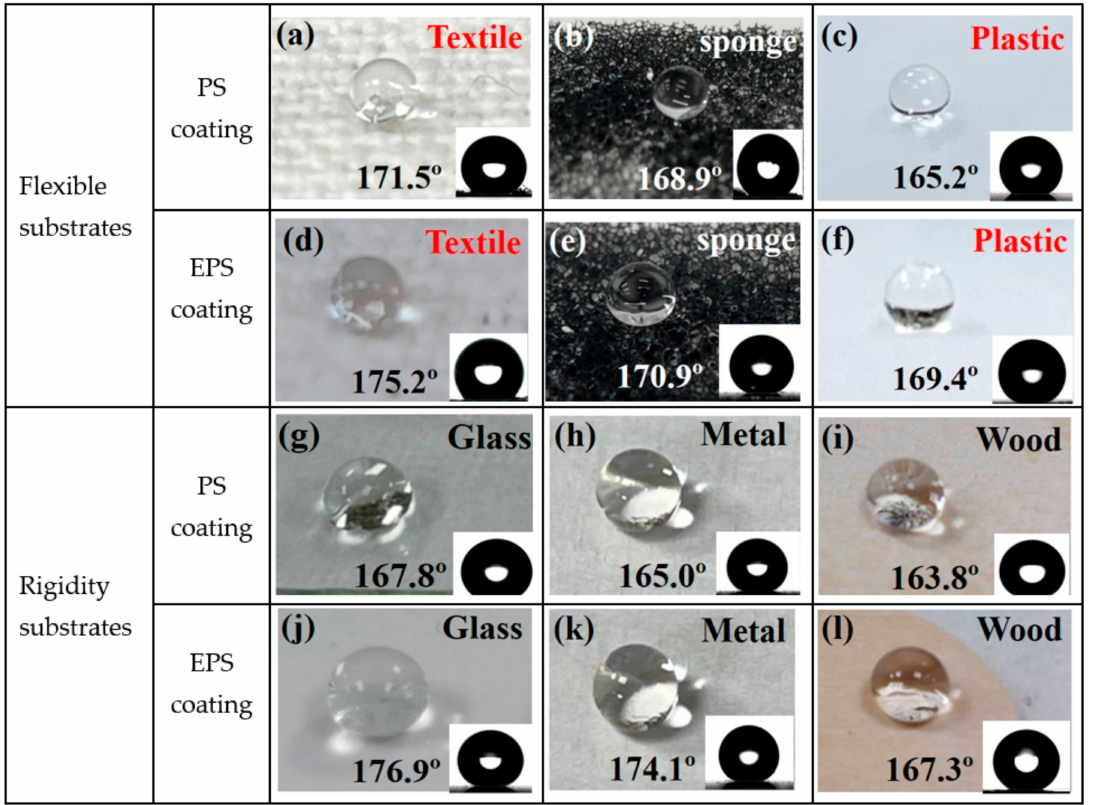
Figure 3. ( a – f ) Optical images of blue water droplets on flexible substrates coated with PS and EPS, such as textile, sponge, and plastic surfaces. ( g – l ) Optical images of water droplets on rigid substrates coated with PS and EPS, such as glass, wood, and metal substrates. Insets: Optical images and CAs of water droplets on the